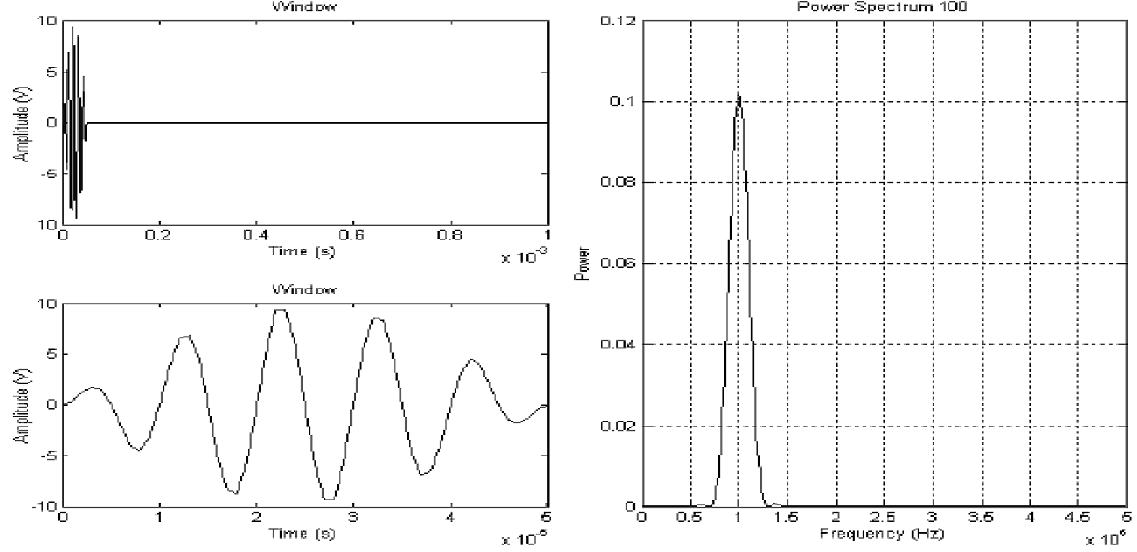
Fig. 9. Modulated sine actuation wave – time and frequency domain